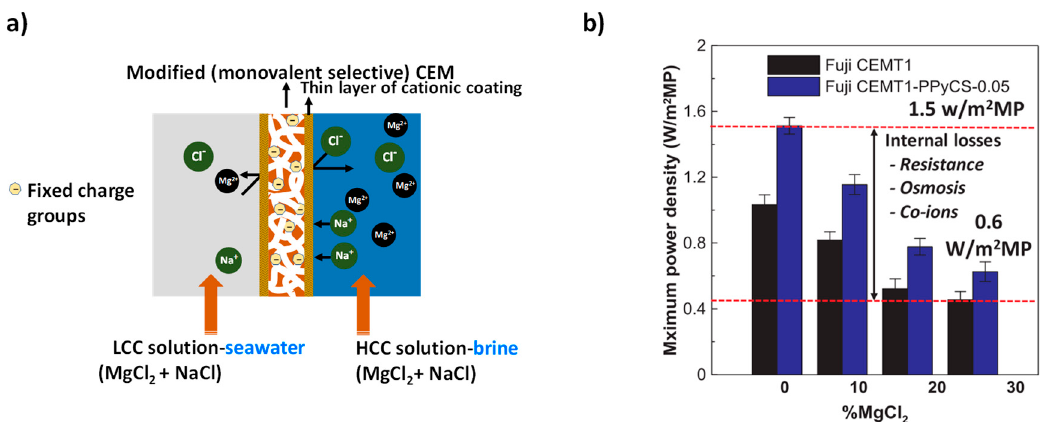
Figure 7. ( a ) Mitigation of uphill transport using monovalent selective cation exchange membrane. LCC: low concentration solution; HCC high concentration solution; CEM: cation exchange membrane. ( b ) Enhancement in OCV and power density with the monovalent selective membranes based on polypyrrole/chitosan composites. Reproduced with permission from [39]. Copyright 2016 Elsevier.